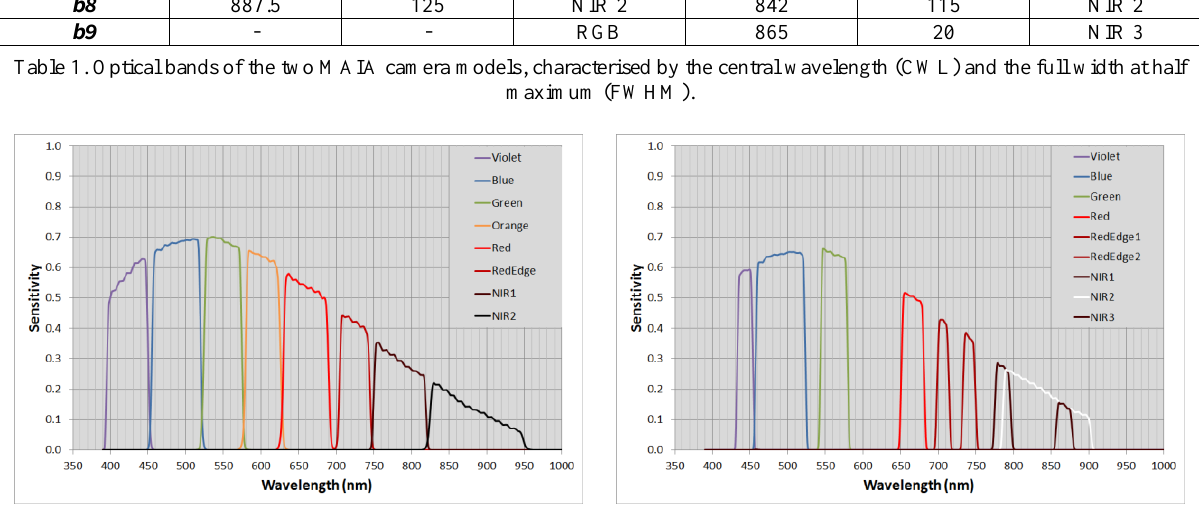
Figure 2. Sensitivity of the optical bands of MAIA (a) and MAIA/S2 (b) cameras. The sensitivities are the products of the quantum efficiency of the sensors and the transmittance of the filters.